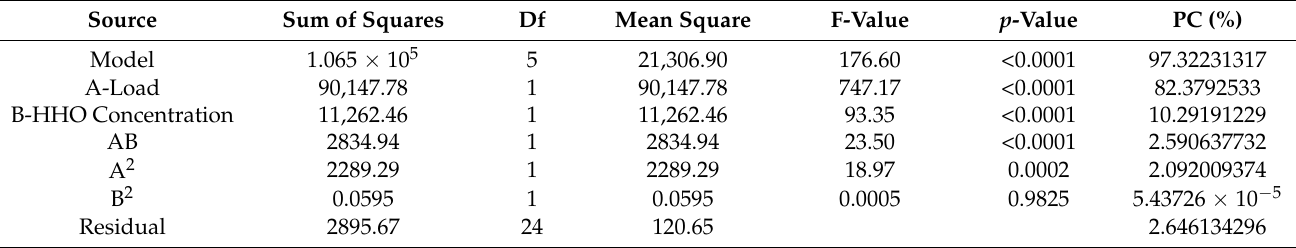
Table 9. ANOVA results for